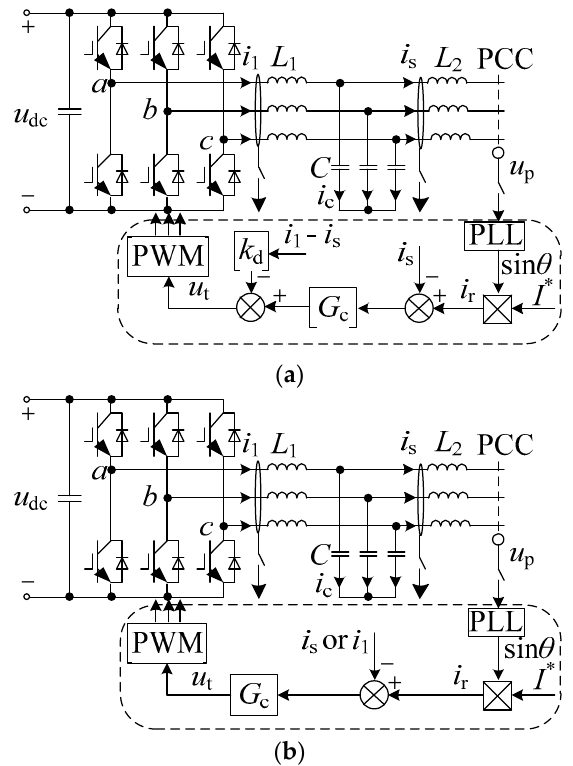
Figure 2. Inverter control structure: ( a ) dual-loop control structure; ( b ) single-loop control with grid-side current feedback or with inverter-side current feedback.